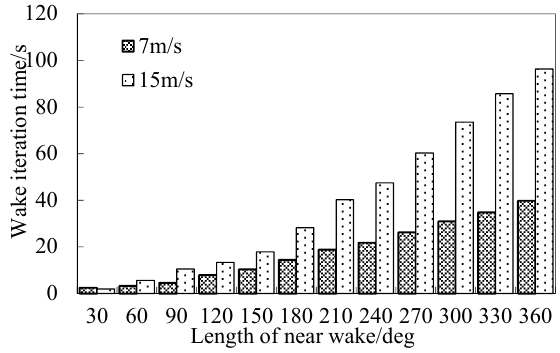
Figure 8. Wake iteration time along the length of the near wake at 7 m/s and 15 m/s.